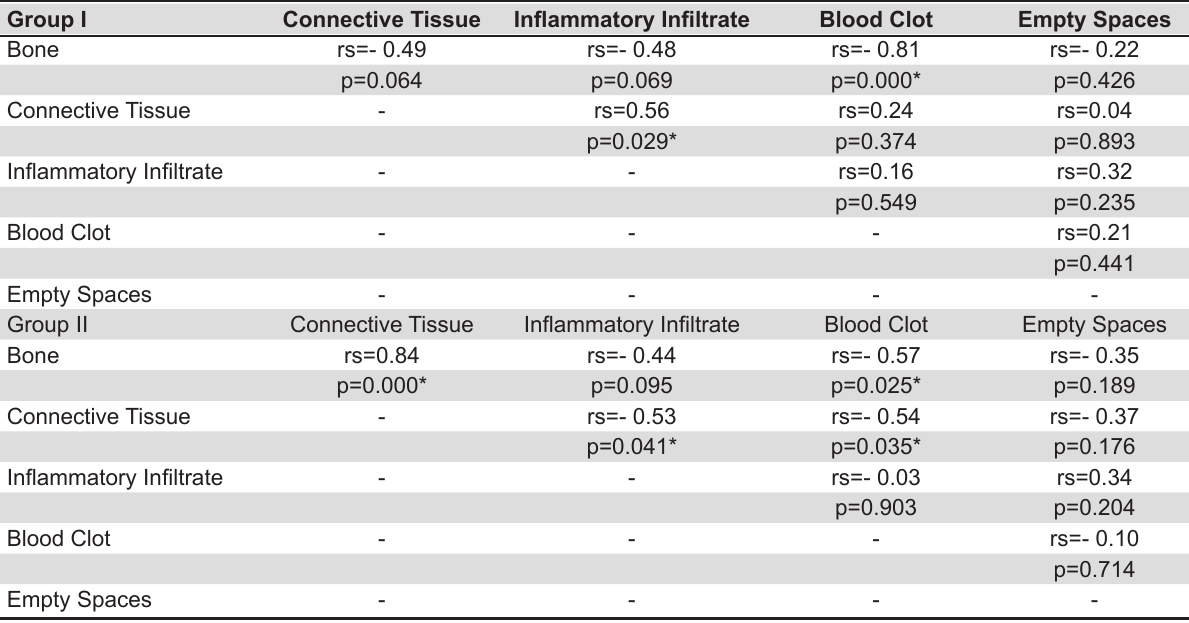
Results of Spearman’s correlation test (rs) and p value of variables in Group I and Group II. *statistically significant correlation (p<0.05)